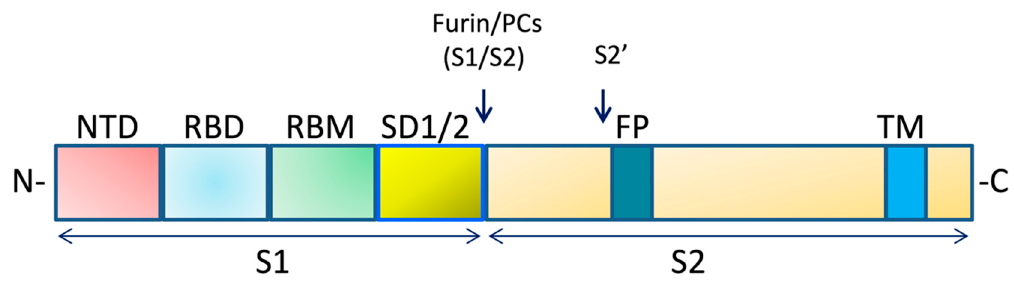
Figure 1. Schematic domain representation of the Spike glycoprotein. The diagram includes the functional domains in the S1 subunit (NTD, N-terminal domain; RBD, receptor-binding domain; RBM, receptor-binding; SD1/2: subdomain 1 and 2) and in the S2 subunit (FP, fusion peptide; TM, transmembrane domain. The N- and C-terminal domains are indicated. Arrows denote the protease cleavage sites. PCs: Proprotein convertases.